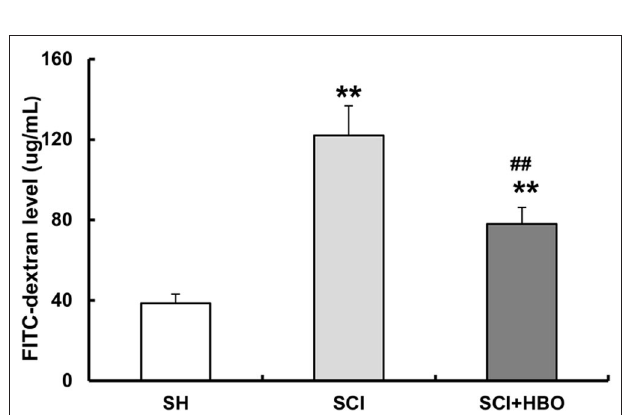
FIGURE 2 | Effect of HBO on the intestinal permeability of SCI rats on postoperative day 3. Data are presented as mean ± SD. Compared with the SH group, there was a significant increase in the leakage of FITC-dextran from the gut in the SCI and SCI + HBO groups (** P < 0.01); HBO treatment significantly decreased the leakage of FITC-dextran compared with the SCI group ( ## P < 0.01). HBO, hyperbaric oxygen; SCI, spinal cord injury; FITC, fluorescein